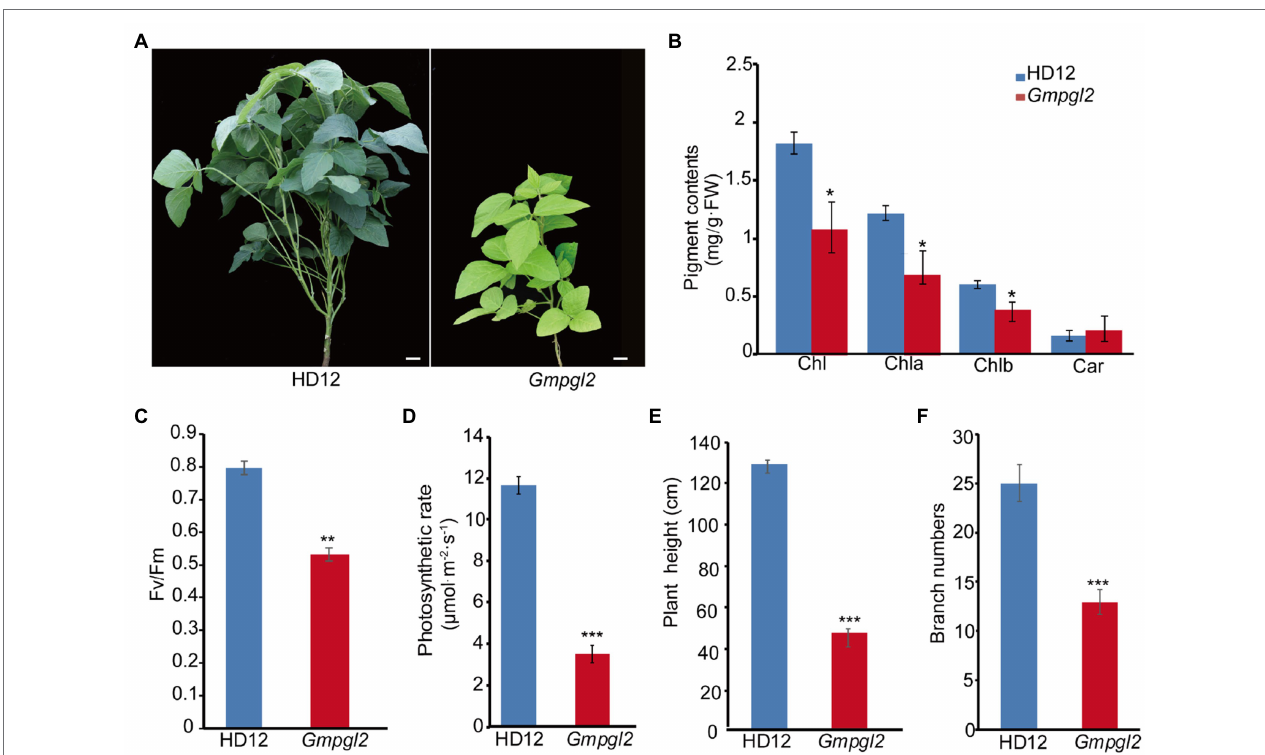
FIGURE 1 | Phenotypes of Hedou12 (HD12; wild type) and Gmpgl2 (mutant) plants. (A) Leaves of HD12 and Gmpgl2 . Bar = 5 cm. (B) Pigment content in 18-day- old HD12 and Gmpgl2 seedlings. Chla , chlorophyll a; Chlb , chlorophyll b; and Car , carotenoid. (C) Photosystem II maximum quantum yield ( Fv/Fm ) photosynthetic rate of 18-day-old HD12 and Gmpgl2 seedlings. (D) Photosynthetic rate of 18-day-old HD12 and Gmpgl2 seedlings. Values are mean ± SE of three biological replicates. Asterisks denote significant differences from HD12, as determined using Student’s t -test. (E) Height of HD12 and Gmpgl2 mutant plants. (F) Number of branches in HD12 and Gmpgl2 mutant